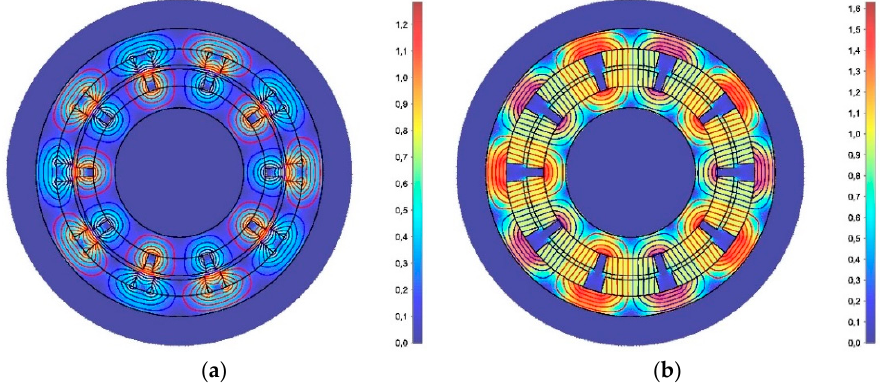
Figure 5. Overview of parametrized PM rotor topologies used in design optimization with surface mounted topologies a–c being most suitable for high torque density; ( a ) anti-aligned magnets resulting in unstable equilibrium with maximum energy stored in PM; ( b ) aligned magnets resulting in stable equilibrium; no energy stored in PM.